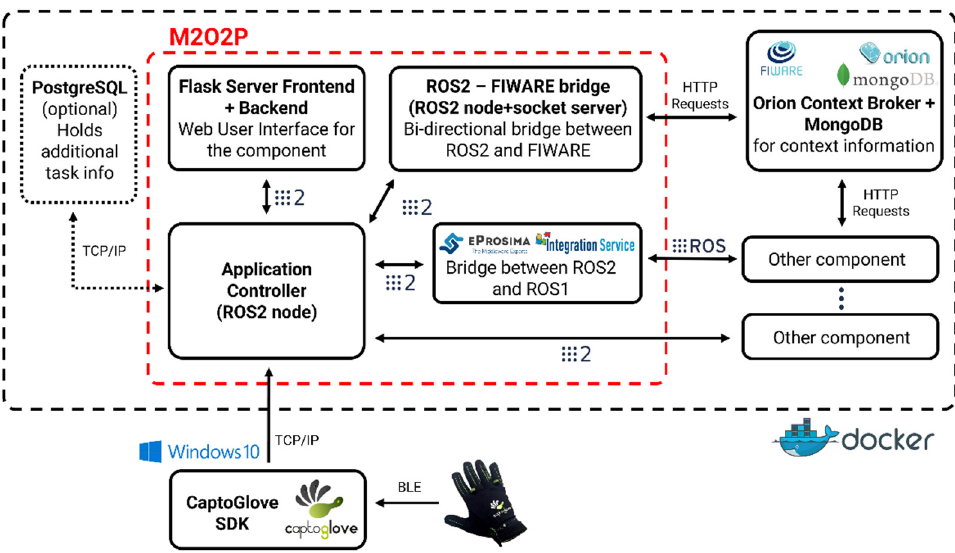
Figure 5. M2O2P architecture, where inside the red dashed box is the modules of M2O2P. These M2O2P modules in addition to other modules and components are all containerized, as shown inside the black dashed box. M2O2P consists of three main modules, AC, Web UI, and ROS2-FIWARE bridge, and additionally the eProsima’s © Integration Service. These modules interact with each other using ROS2 and with other components with FIWARE, ROS2, ROS1, and PostgreSQL.